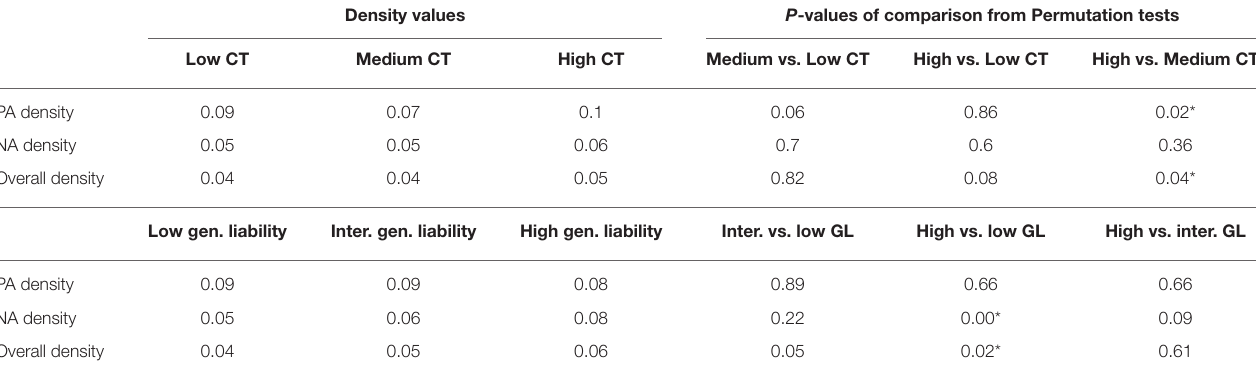
TABLE 2 | Emotional density across levels of childhood trauma and genetic liability,